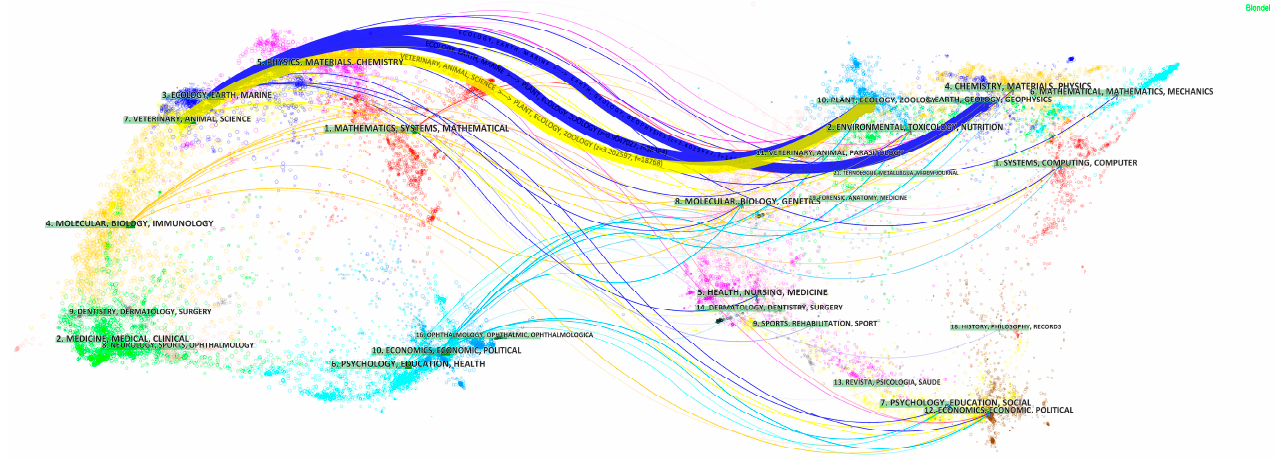
Figure 6. The dual-map overlay.